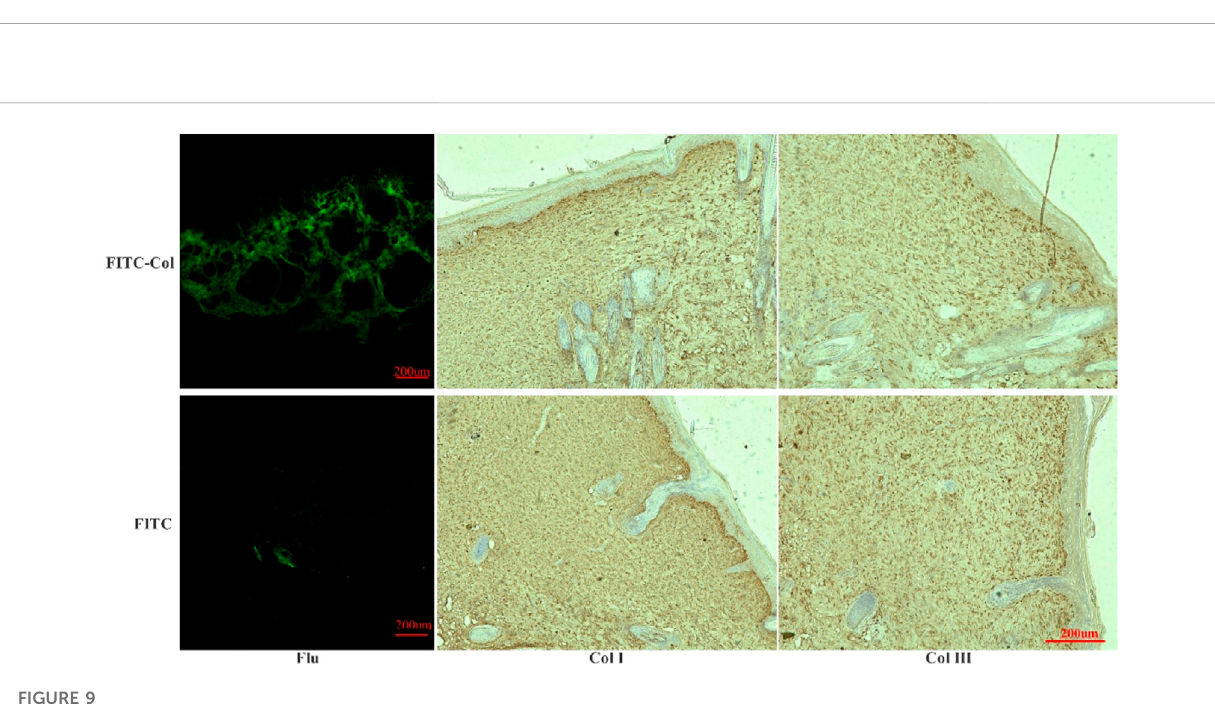
FIGURE 8 Fluorescence distribution of FITC and FITC-Col at different time points after implantation. (A) FITC-Col (FITC-labeled fi sh collagen); (B) FITC; I: Fluorescence distribution in the whole body of rats at different time points; II: Fluorescence distribution of different organs on 7th day). Note: The green fl uorescence in this image shows FITC or FITC-labeled collagen.